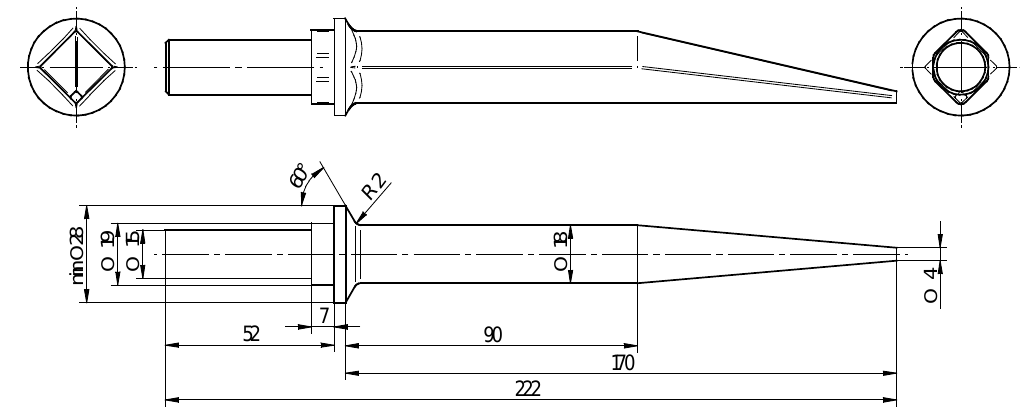
Figure 1. Harrow tooth forging (on top) and preform manufactured by cross-wedge rolling (on the bottom).